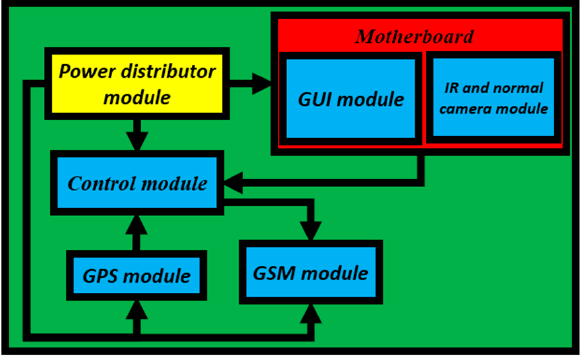
Figure 20. Block diagram of the intercommunication of the internal modules of SOMN_IA.